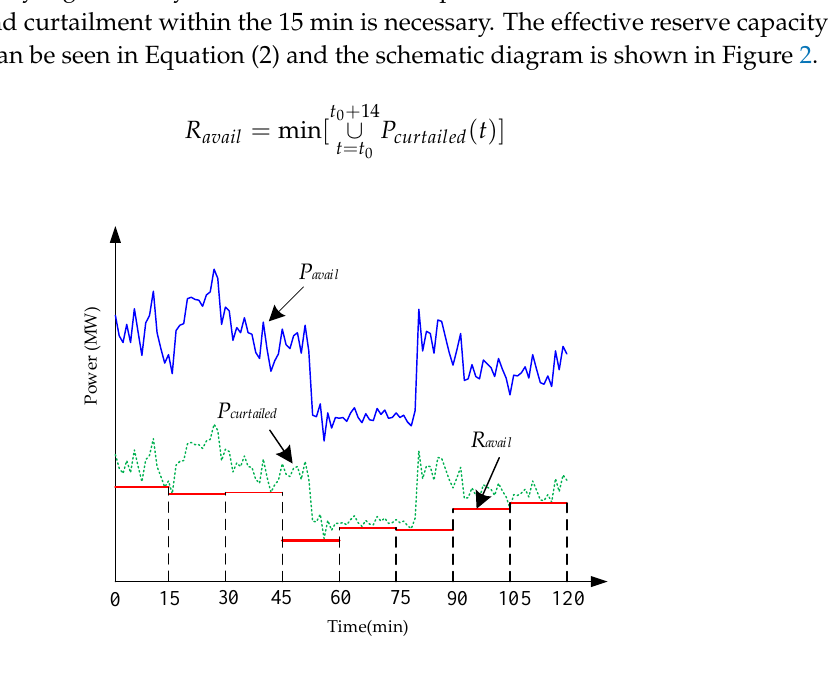
Figure 2. Diagram of the effective reserve capacity.